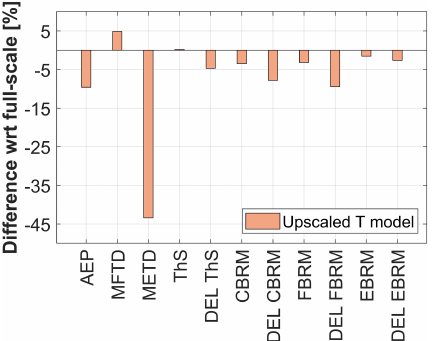
Figure 7. Comparison between full-scale key indicators and the upscaled ones of the T